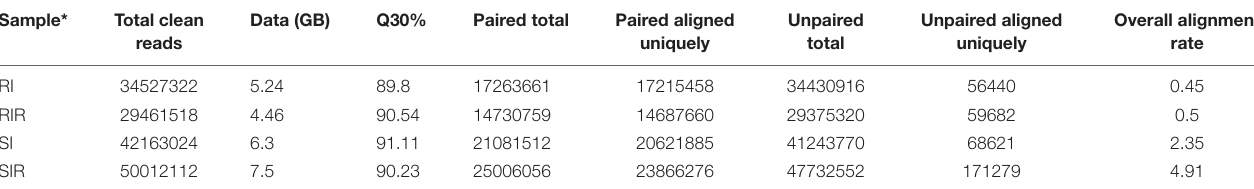
FIGURE 1 | (A) Scanning electron micrograph showing abundant fungal hyphae in susceptible (CM 119) line after infection with Bipolaris maydis . (B) Symptoms of maydis leaf blight on susceptible CM 119 (score 4) and resistant SC-7 (score 1) and both genotypes under field conditions. TABLE 1 | Summary of the Illumina sequence reads obtained from Zea mays plants inoculated with B. maydis pathogen grown on sorghum